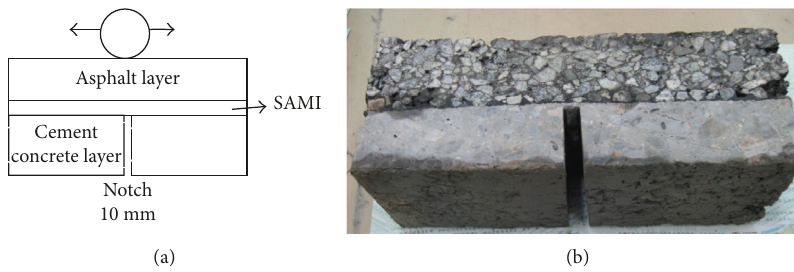
Figure 3: The loading model (a) and beam specimen (b) of the fatigue cracking test.